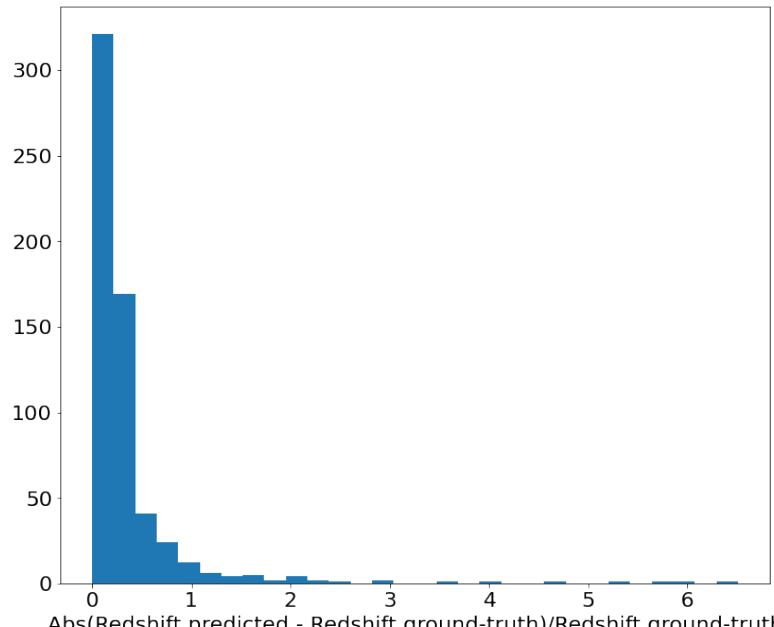
Figure 7. Histogram of the relative error in the estimated distance with respect to true